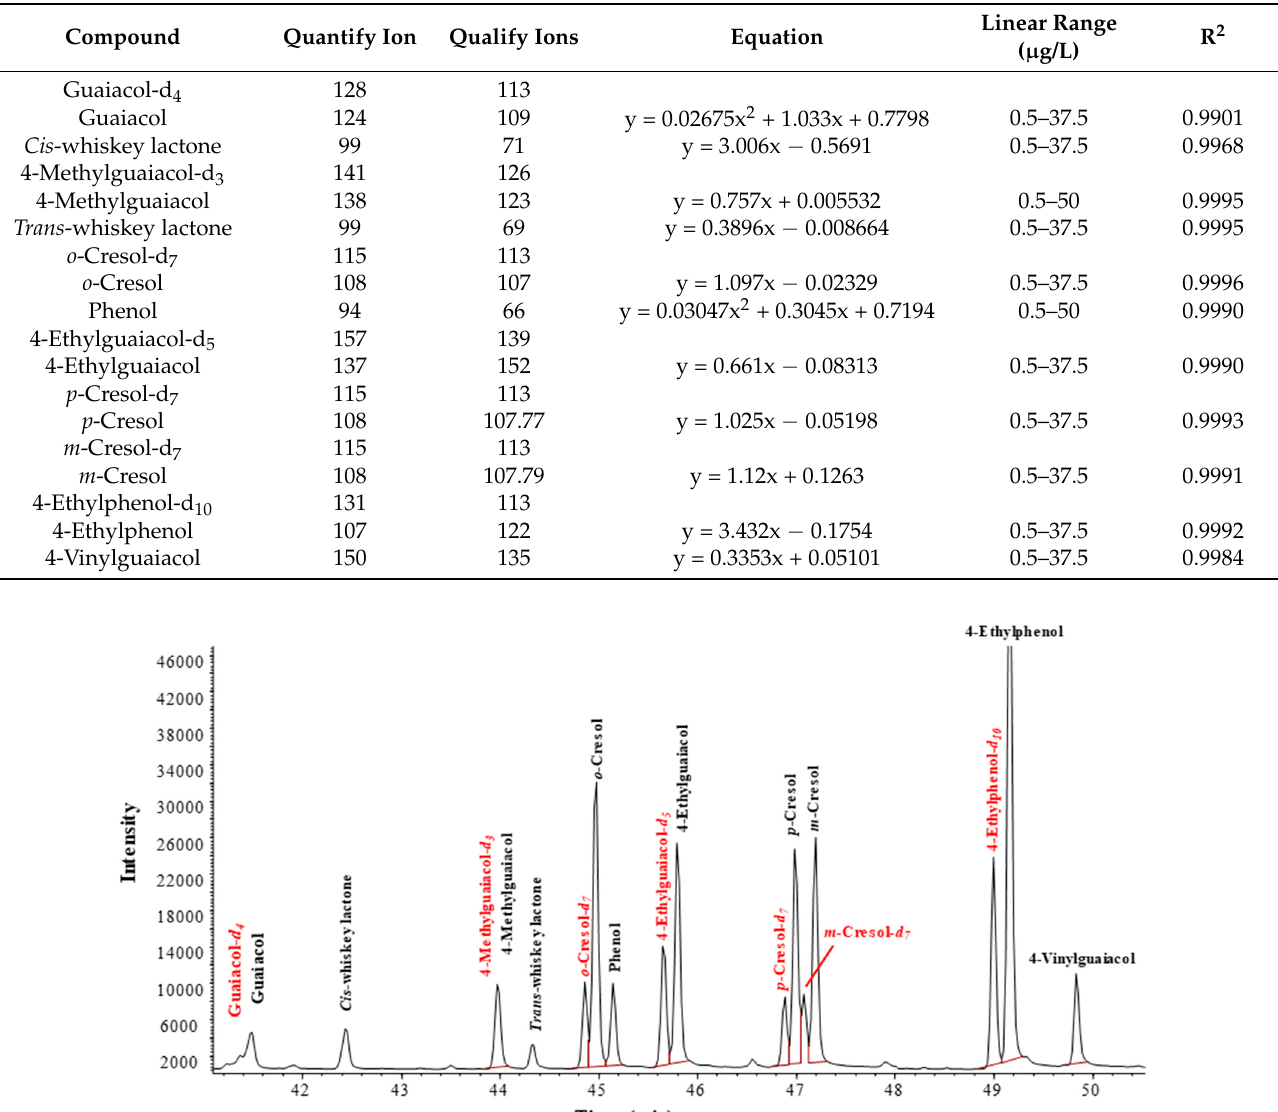
Table 1. Internal standard (IS), retention time (RT), target ions, calibration equations, standard range, linearly dependent coefficient (R 2 ) of volatile compounds in smoke-tainted wines using SBSE-GC-MS.